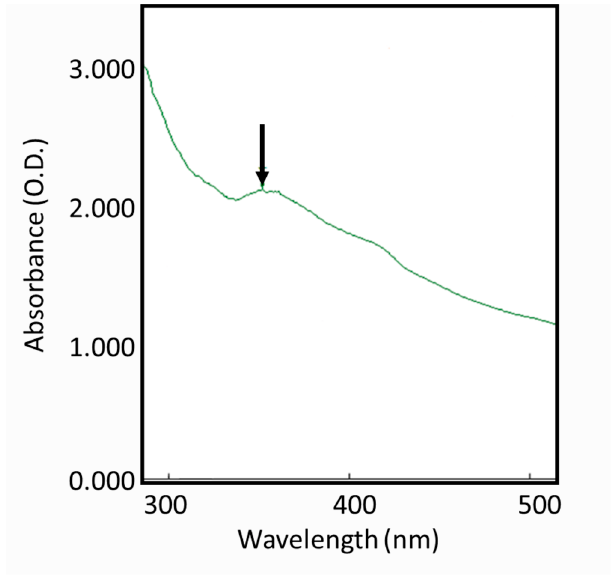
Figure 1. UV − Visible spectra of Spondias mombin leaf extract mediated silver nanoparticles.